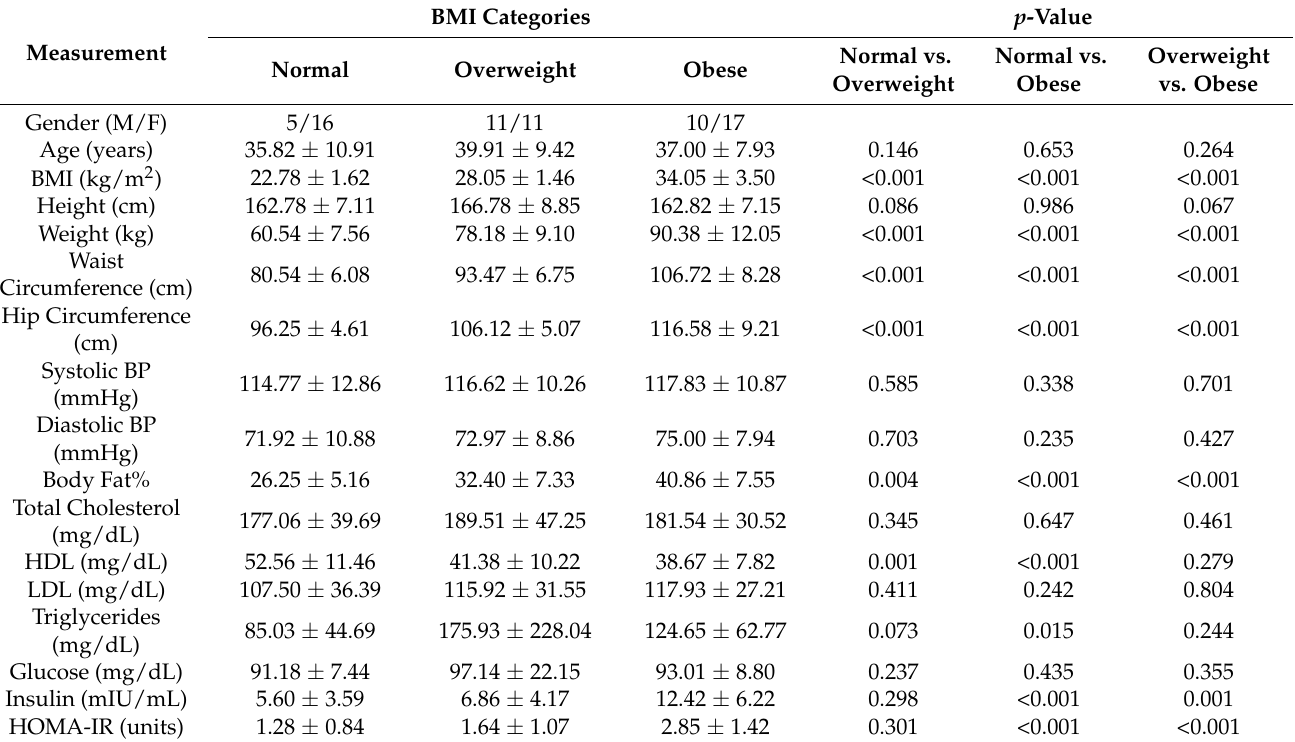
Table 1. Baseline data between normal, overweight, and obese